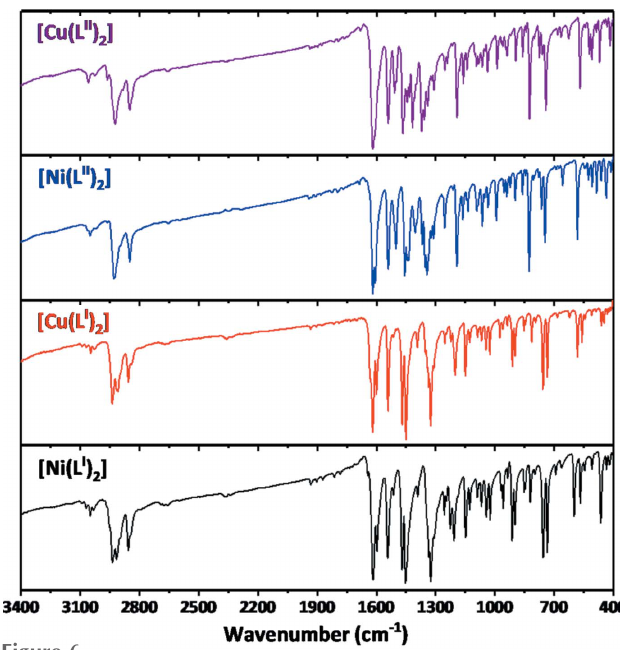
Figure 6 FTIR spectra of [Ni( L I,II ) 2 ] and [Cu( L I,II ) 2 ]. C—H (cid:2) (cid:2) (cid:2) O interactions can be both attractive and repulsive